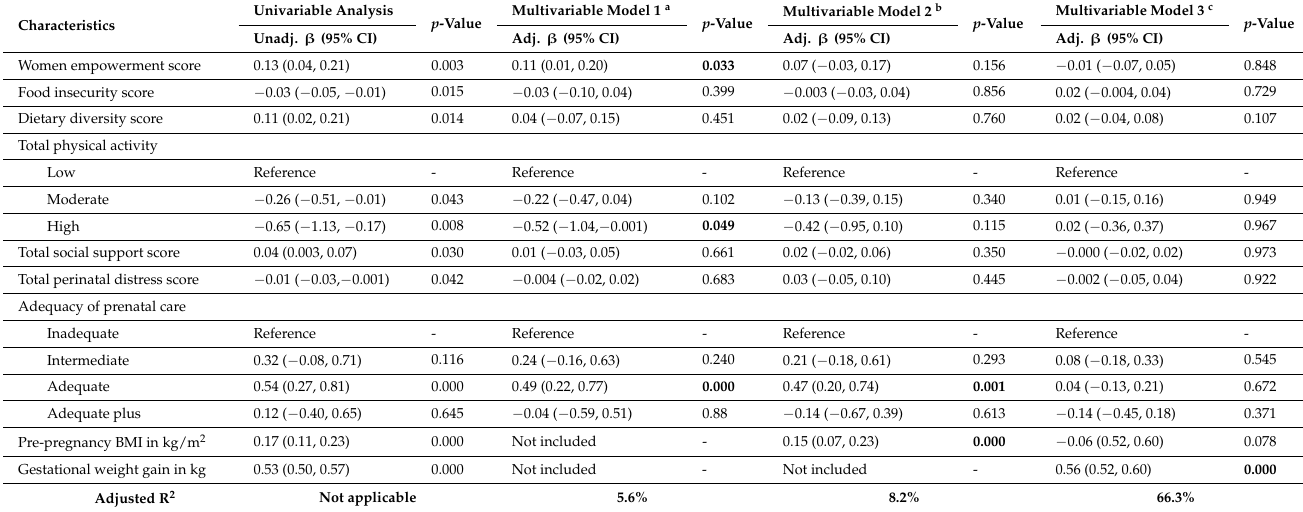
Table 2. Linear regression analysis of factors associated with postpartum weight change in